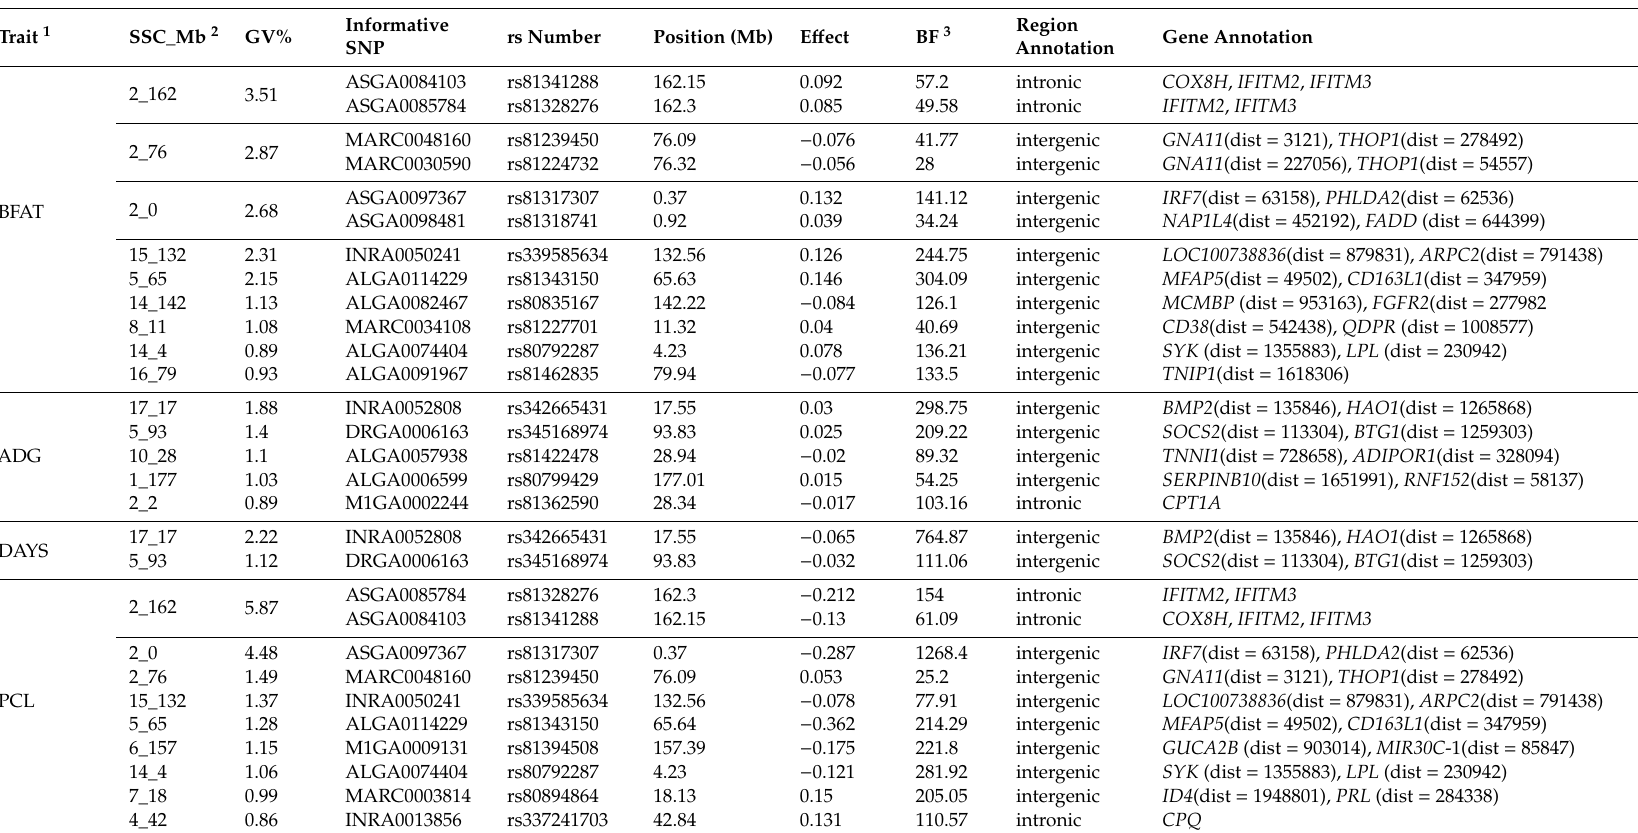
Table 2. Informative 1-Mb genome windows and single nucleotide polymorphisms (SNPs) within windows associated with growth rate (ADG and DAYS) and production (BFAT and PCL) traits in Yorkshire pigs from the GWAS using markers on Illumina